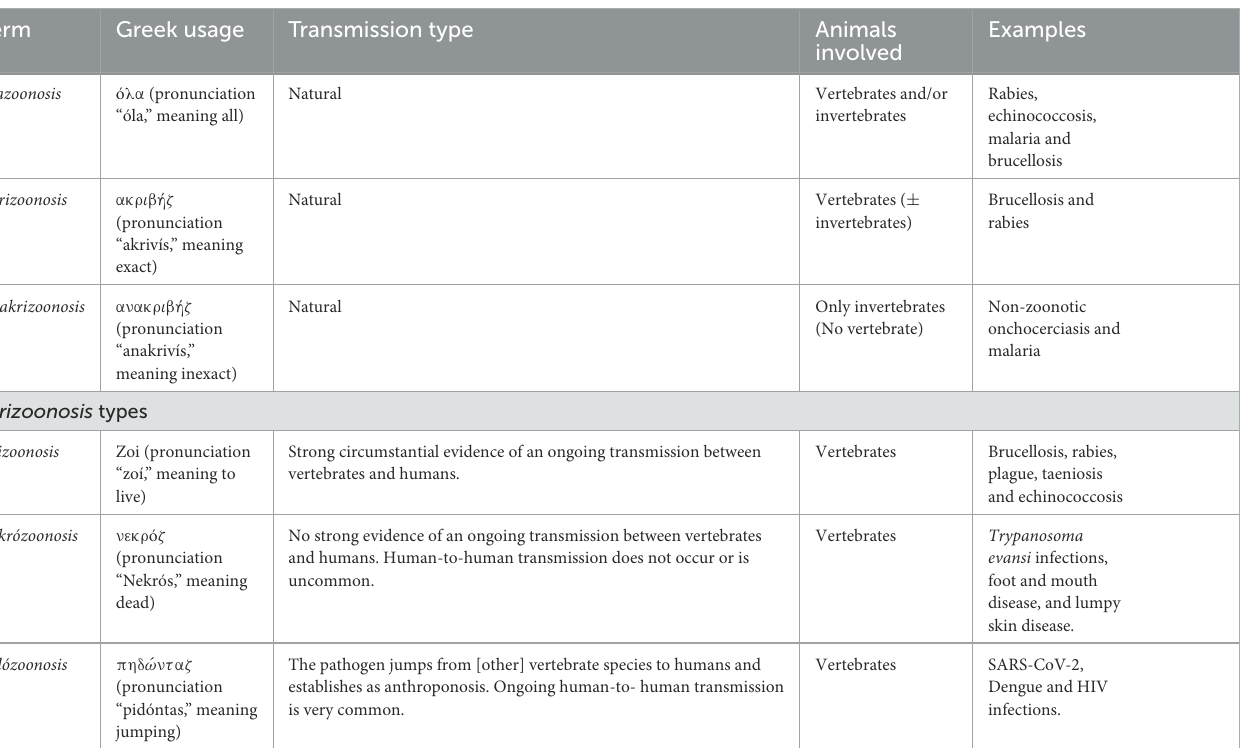
TABLE 1 Criteria used for the classification of different zoonotic diseases.